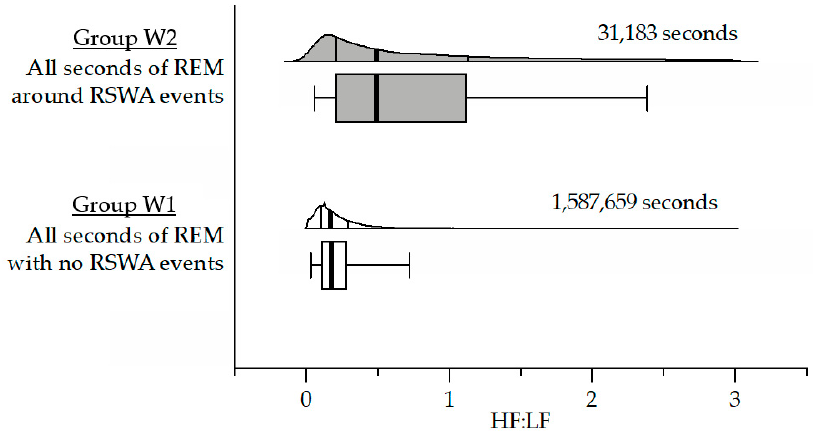
Figure 4. Window-based HF:LF analysis: horizontal violin plots (non-truncated/halved) with corresponding box-whisker plots illustrating the HF:L:F spread across Group W1 (open plot; the HF:LF in every second of REM sleep with no REM sleep without atonia), and Group W2 (light shaded plot; the average HF:LF in the 3 s window around every REM sleep without atonia event). The heavy solid line corresponds to the median value with the 25th and 75th percentile indicated by the bracketed lines/box outline. Whiskers indicate the 5th and 95th percentiles.